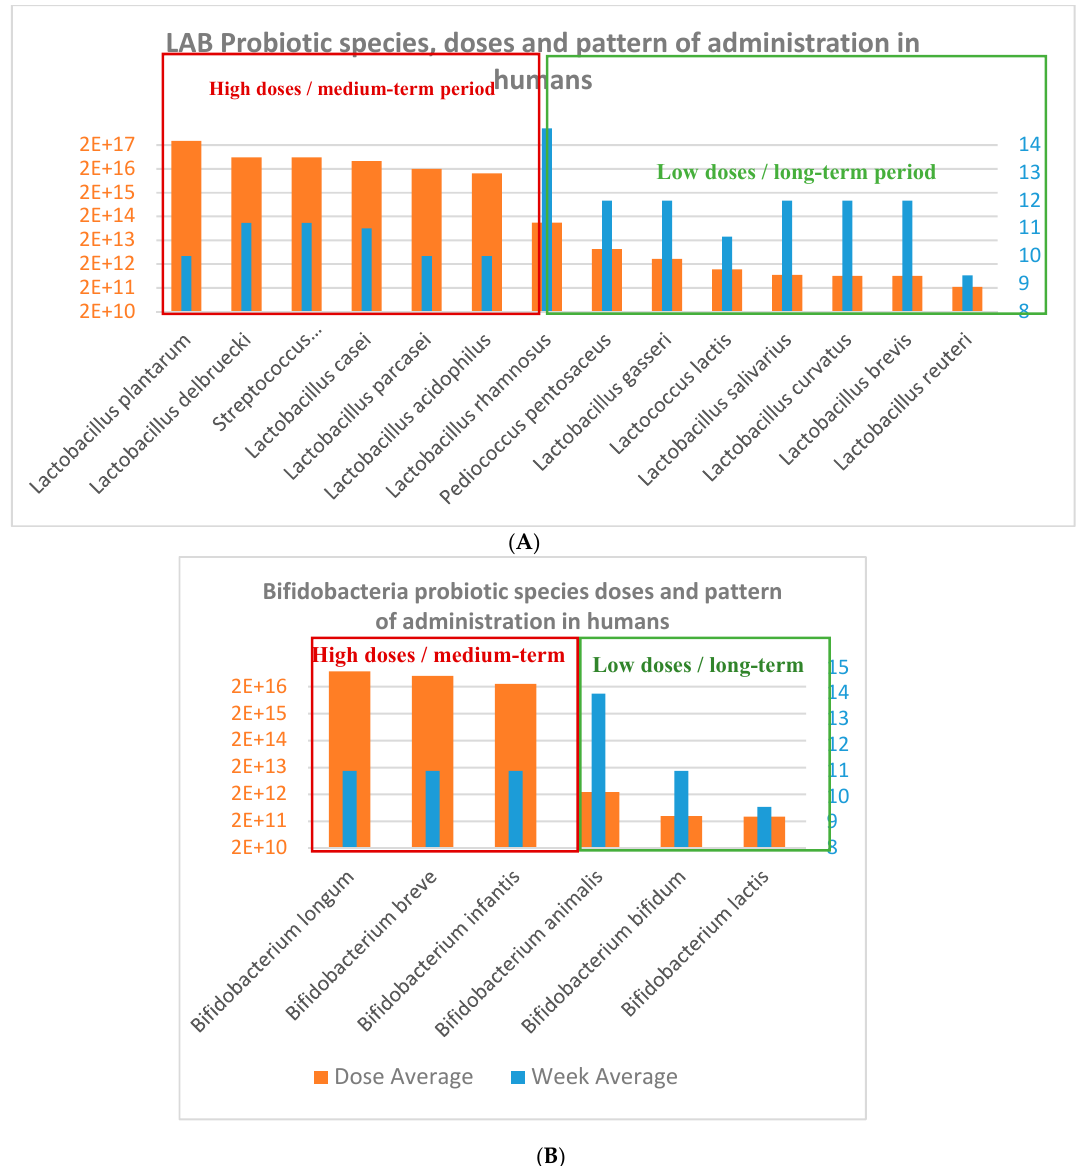
Figure 3. ( A ) Lactobacillus and Lactic Acid Bacteria (LAB) species and ( B ) Bifidobacterium species used in obesity-related disorders from human clinical trials.